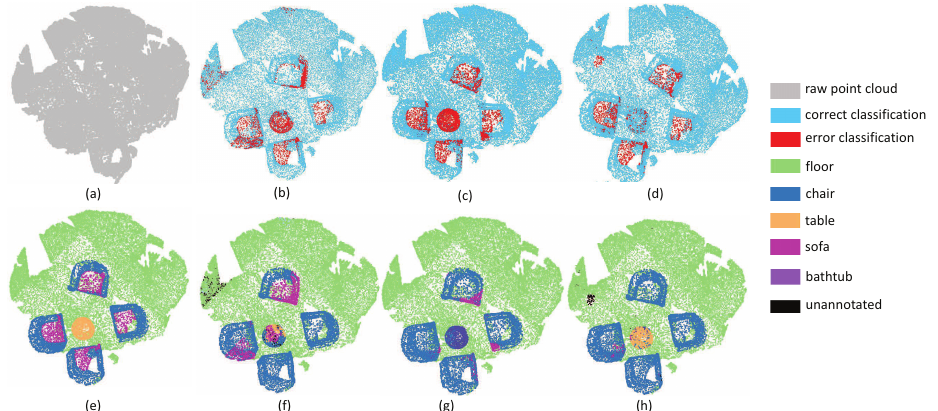
Figure 7. The small object segmentation results on Lounge . ( a ) input, ( e ) ground truth, ( b , f ) the classification result by PointNet++, ( c , g ) the classification result by PointSIFT, and ( d , h ) the classification result by SAN.